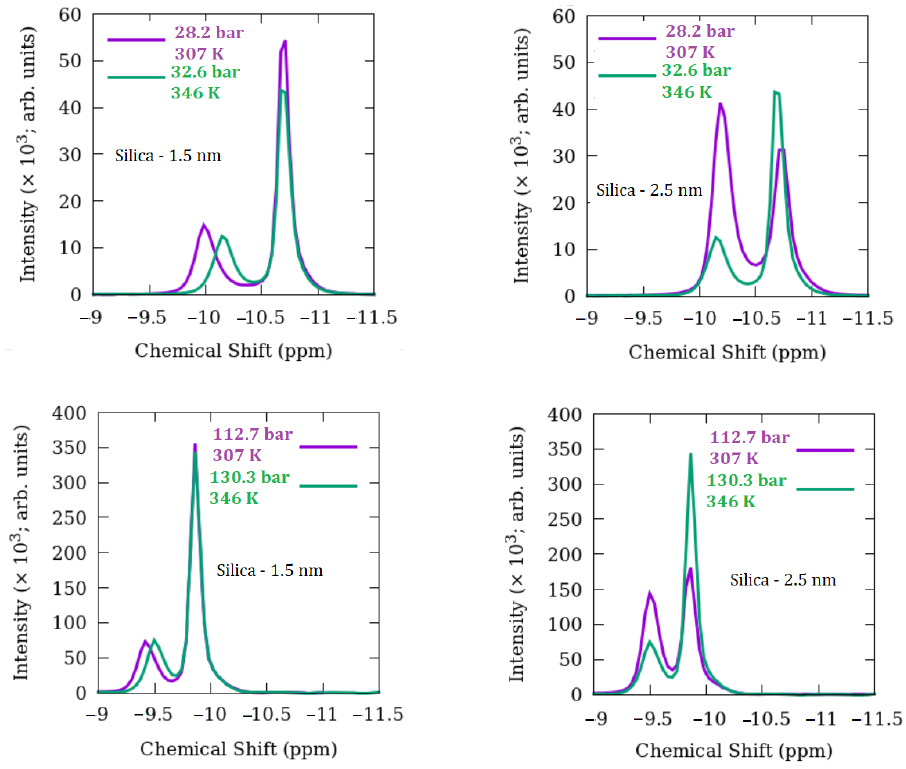
Figure 2. Proton decoupled 13 C MAS NMR spectra of methane in engineered nanoporous